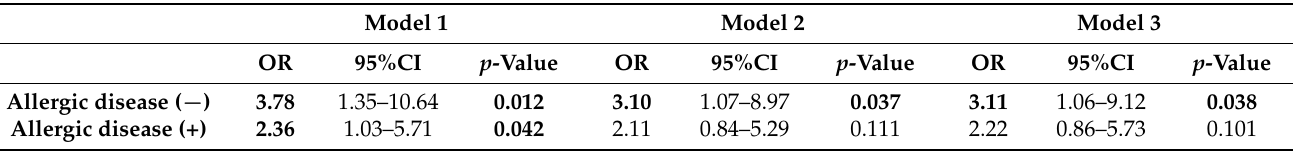
Table 4. Association between alcohol consumption and a high IgE level by the presence or absence of allergic disease (IgE ≥ 173